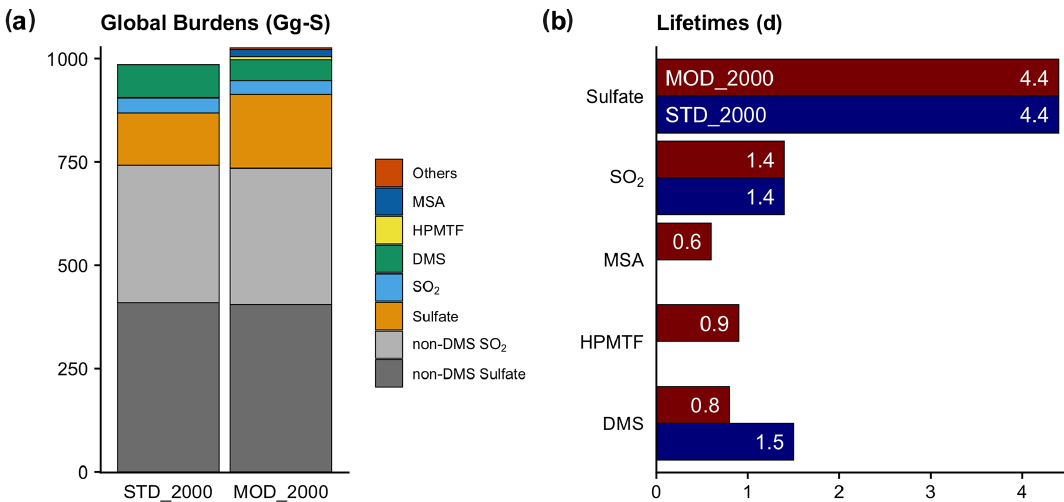
Figure 4. (a) Global burdens of various atmospheric sulfur species in our simulations. The category of “Others” includes all other sulfur- containing intermediates in the new chemistry (DMSO, MSIA, etc.). SO 2 (blue) and sulfate (orange) refer to the burden of these species that originate from DMS oxidation only; non-DMS contributions are shown in gray. (b) Total lifetimes of the atmospheric sulfur species to both physical and chemical